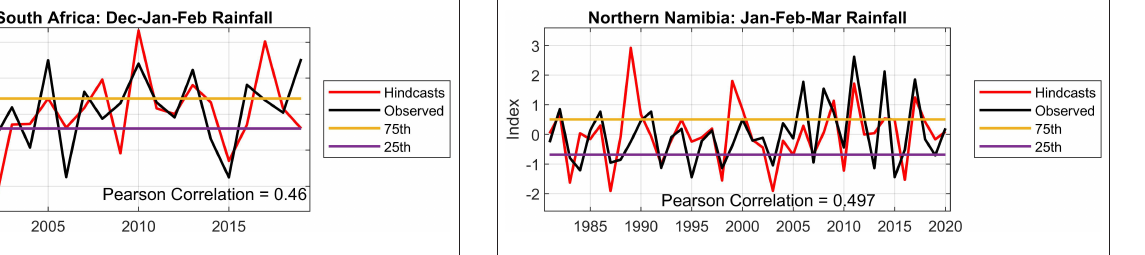
FIGURE 4 | As for Figure 1 , but for the Jan-Feb-Mar rainfall of the farm located in the northern interior of Namibia. The correlation value’s level of confidence is at the 99.99% level.